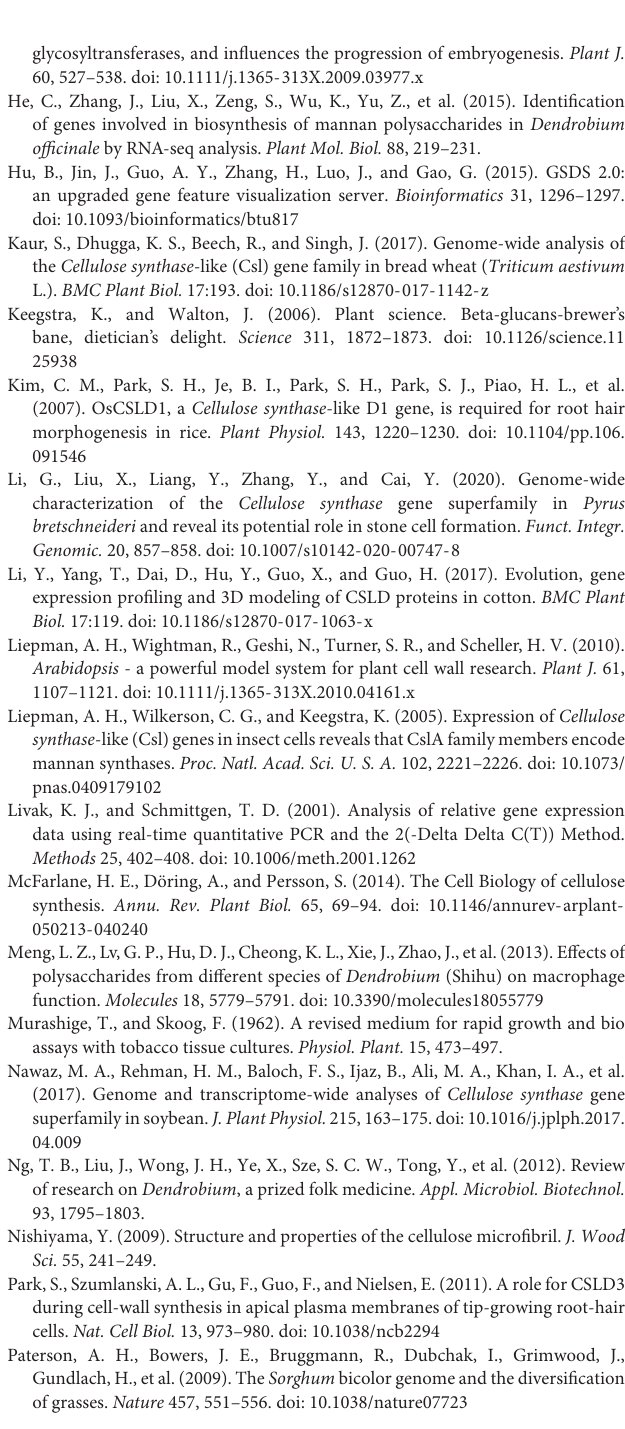
Supplementary Figure S5 | Multiple alignment and motif logos of D. officinale . (A) Multiple comparisons of the deduced amino acid sequences of Cellulose synthase in D. officinale . Conserved cysteine residues are marked by red frames. (B) Sequence logos of the 10 motifs. Supplementary Figure S6 | Multiple alignment of the deduced amino acid sequences of Cellulose synthase s in P. equestris . Conserved cysteine residues are marked by red frames.